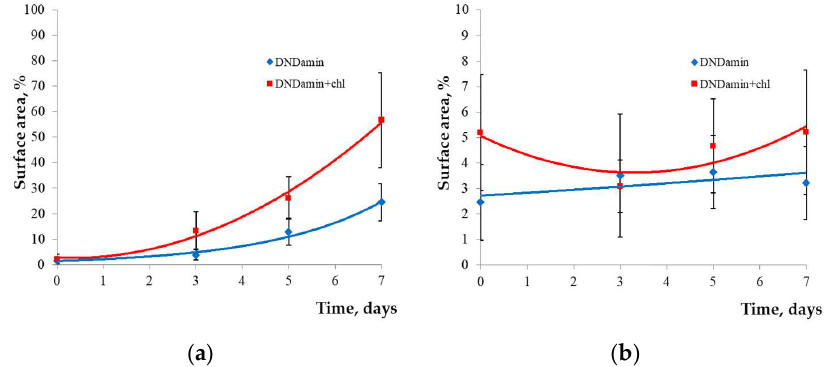
Figure 6. Processing of confocal microscopy images of samples modified with DNDamine and DNDamine + chl. Change over time of the calculated areas occupied by: ( a ) the polysaccharide matrix; ( b ) Saccharomyces cerevisiae cells.